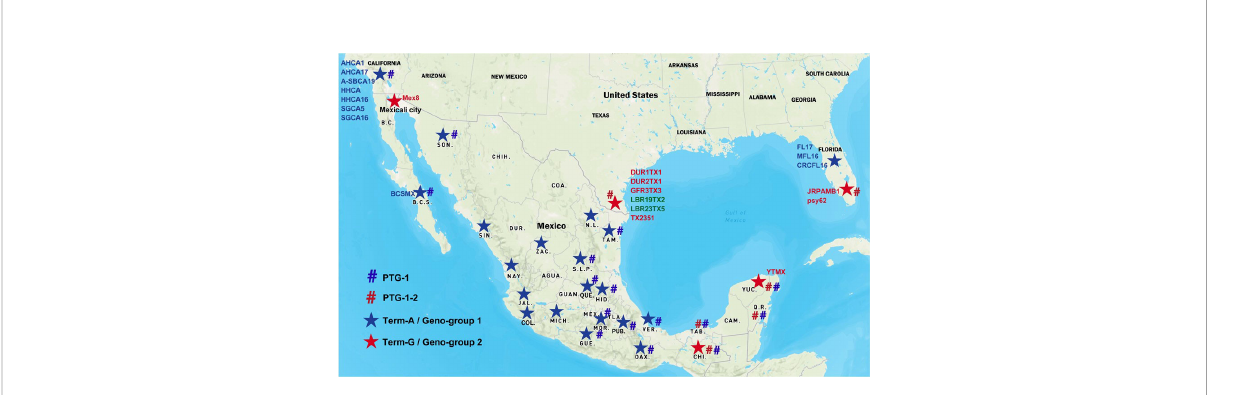
FIGURE 1 Distribution of “ Candidatus Liberibacter asiaticus ” (CLas) strains in Mexico and the United States. Blue star signs represent Term-A group/Geno- group 1; Red star signs represent Term-G group/Geno-group 2. Blue number signs represent PTG-1 prophage group; Red number signs represent PTG-1-2 prophage group. Two CLas strains in green were non-typeable for neither Term-A or Term-G, but determined to be in Geno-group